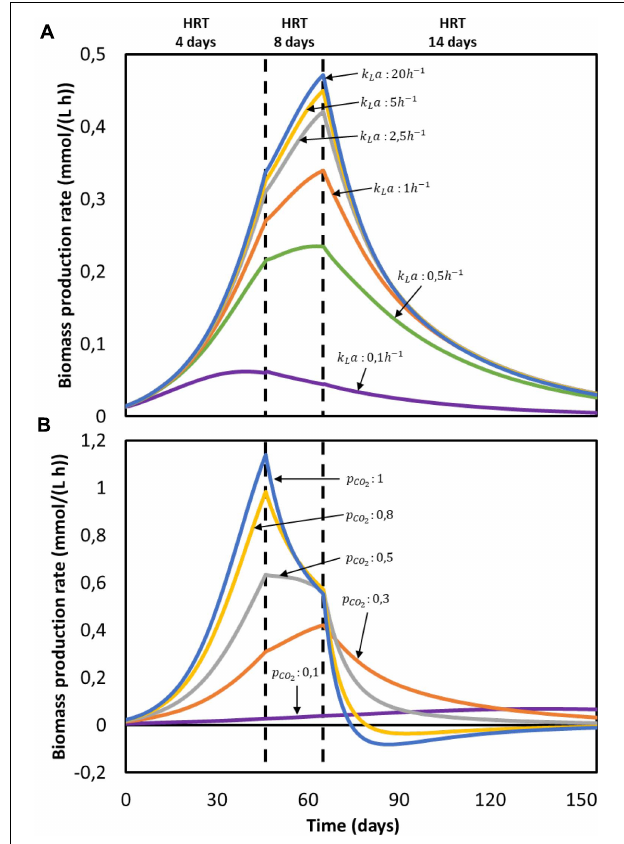
FIGURE 3 | Computed biomass production rate in time for the reactor from Jourdin et al. (2019): (A) at different gas-liquid mass transfer coefficients ( k L a ) = 0 . 3 and (B) at different gas CO 2 partial pressures ( p CO with p CO 2 k L a = 2 . 5 h − 1 . No experimental data